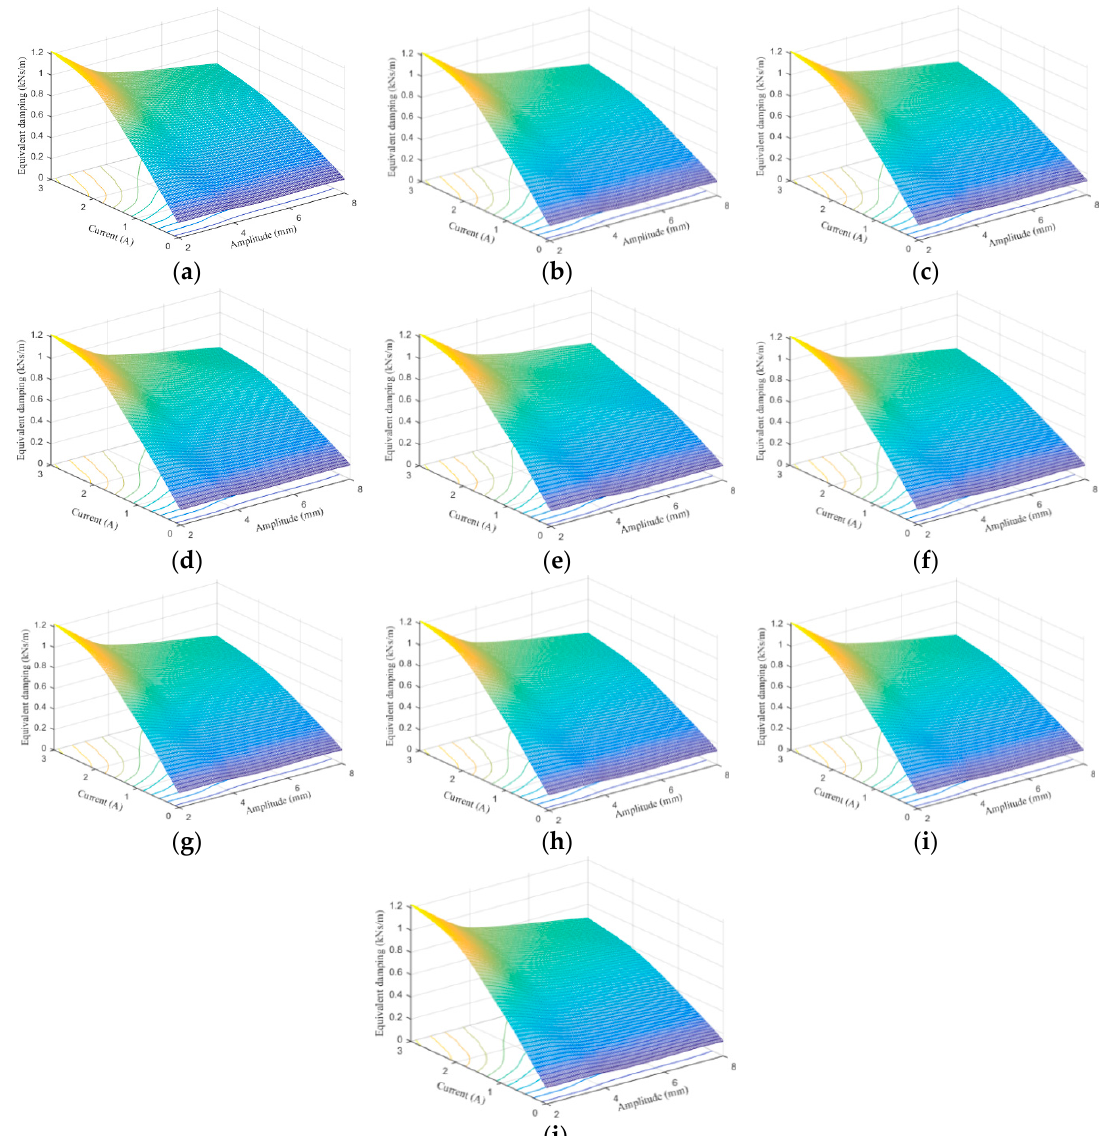
Figure 29. Equivalent damping estimation results of 4 Hz loading frequency. ( a ) Experimental measurement, ( b ) Kelvin–Voigt model, ( c ) four-parameter viscoelastic model, ( d ) rheological model, ( e ) BW model, ( f ) improved BW model, ( g ) Dahl model, ( h ) improved LuGre friction model, ( i ) strain stiffening model, and ( j ) hyperbolic hysteresis model.